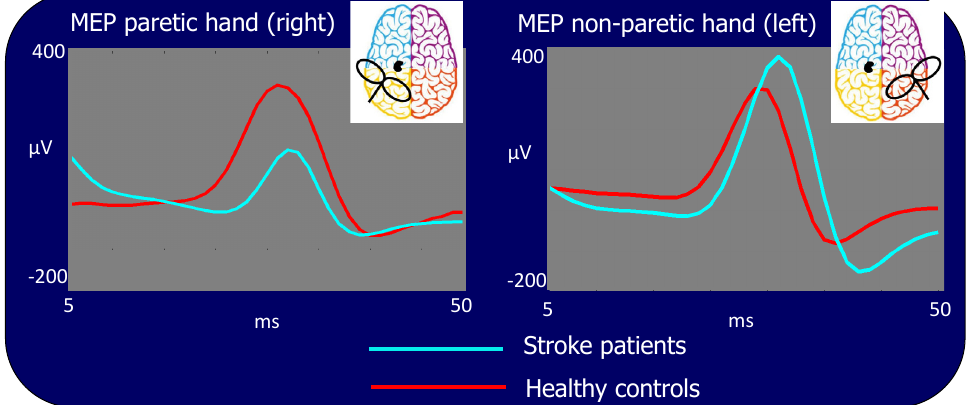
Figure 4. Motor evoked potentials (MEP) for stimulation of the lesioned left and contra-lesion right hemispheres. Time scale refers to t = 0 as the TMS stimulus delivery at the scalp. In light blue: grand average of the patient group, in red: grand average of the control group. The MEP is significantly smaller in patients than in control subjects when TMS is performed in the left lesioned and larger than in controls in the right contra-lesion M1s.